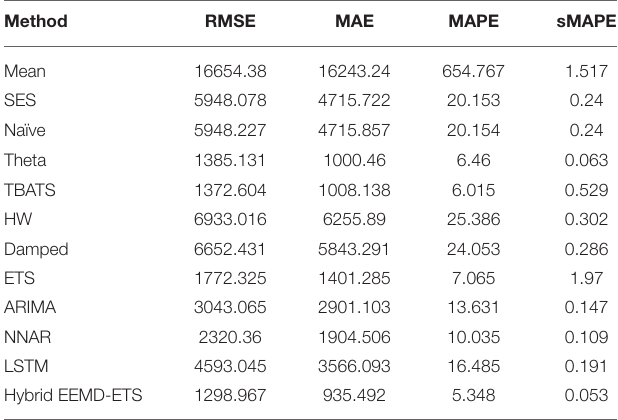
TABLE 9 | Performance comparison of different models for 7 days prediction of Germany’s confirmed cases.